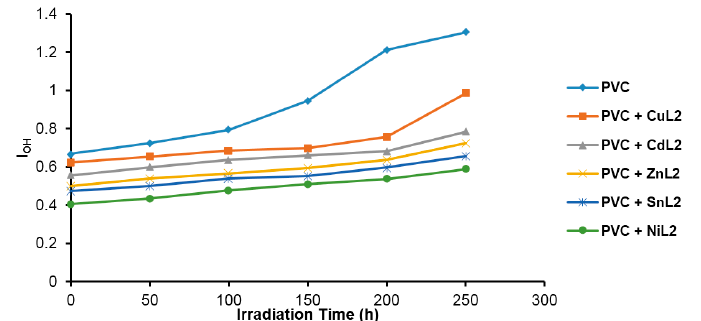
Figure 6. Effect of irradiation time (250 h) on I OH and for PVC films (40 μ m thickness) containing ML 2 (0.5 wt %).